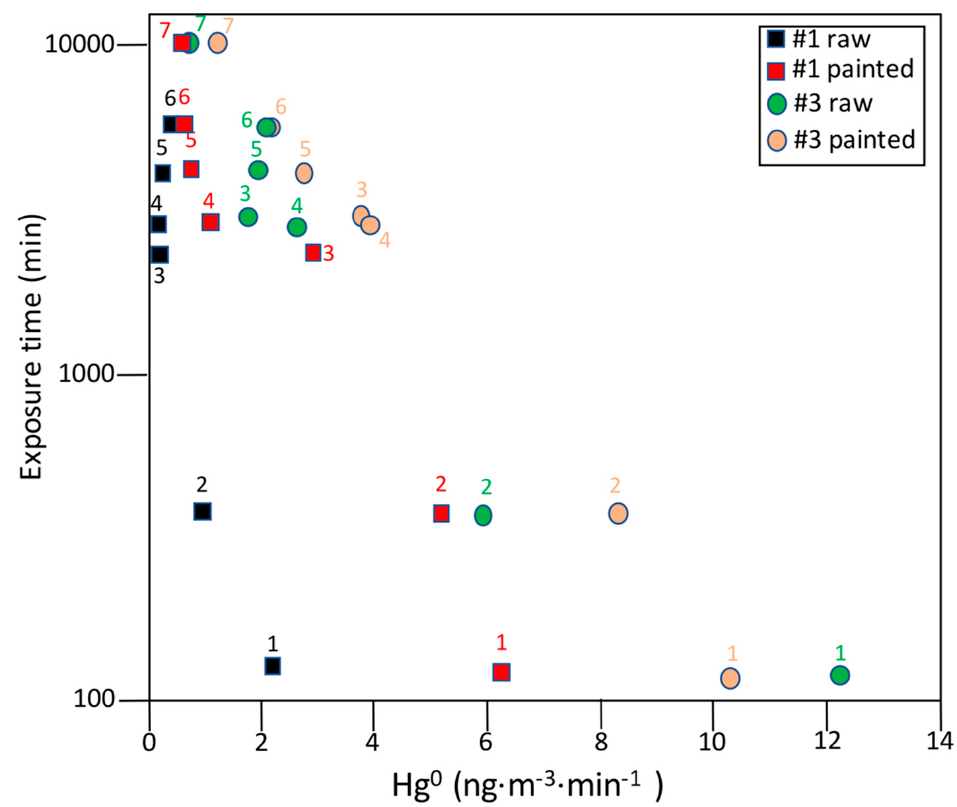
Figure 4. Exposure time vs. rate of released Hg 0 mercury (in ng·m − 3 ·min − 1 ) for samples 1 (“raw” and “painted”) and 3 (“raw” and “painted”). Legend: 1. March 5, 2020 (~2 h); 2. 5 March 2020 (~6 h); 3. 5 March, 2020 (~38 h); 4. 21 March, 2020 (~47 h); 5. 14 March, 2020 (~69 h); 6. 17 March, 2020 (~95 h); 7. 7 March, 2020 (~171 h). The dates represent when the experimental runs started (Table 3).